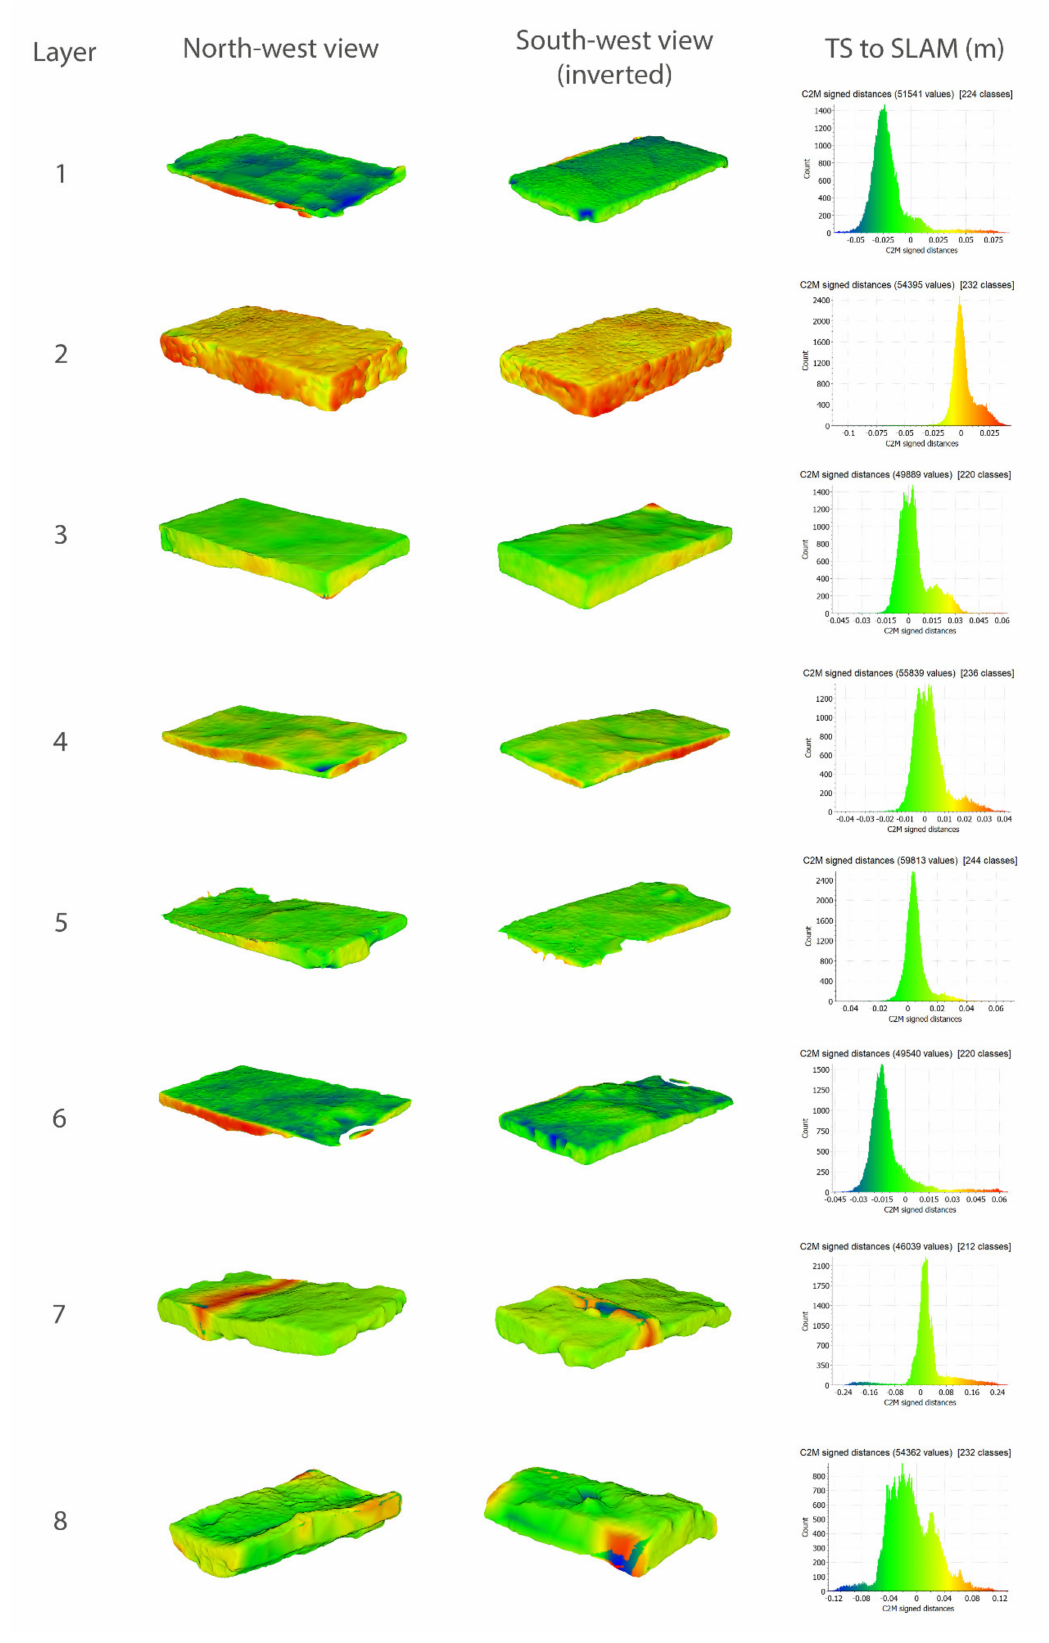
Figure 8. Comparison of the TS mesh onto the SLAM mesh by